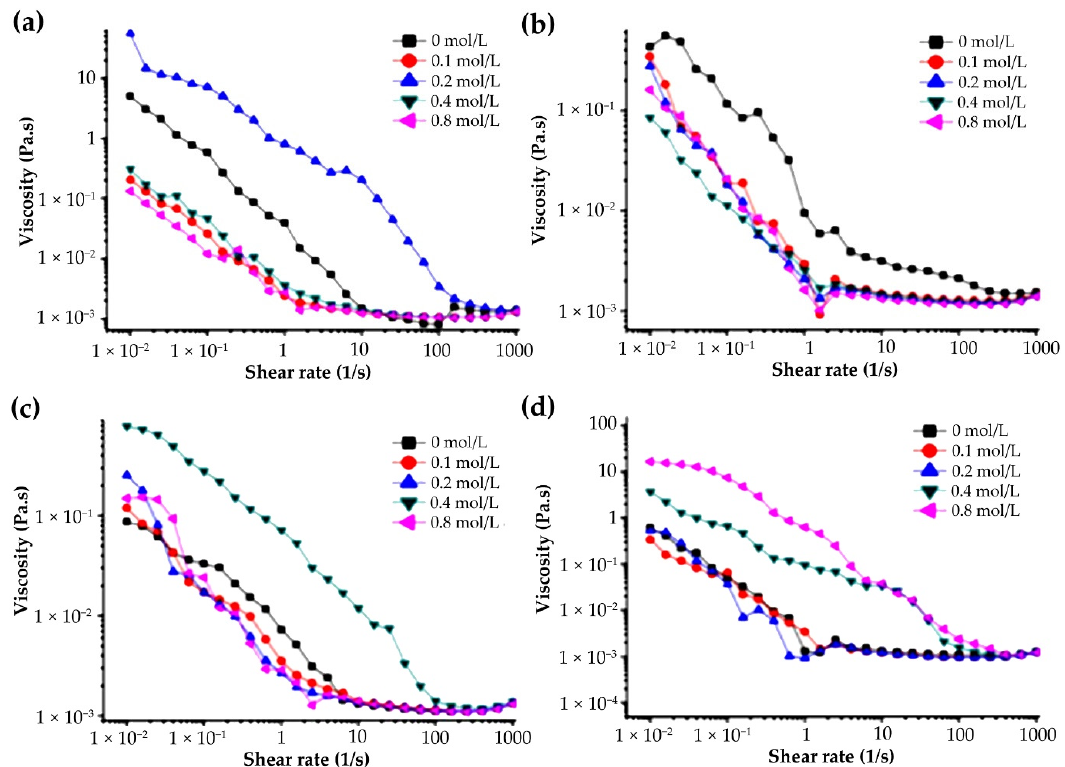
Figure 7. Effect of Na + on the viscosity of G ‐ MLPs (10 mg/mL). ( a ) G ‐ HBSS; ( b ) G ‐ CHSS; ( c ) G ‐ DASS; ( d ) G ‐ CASS.